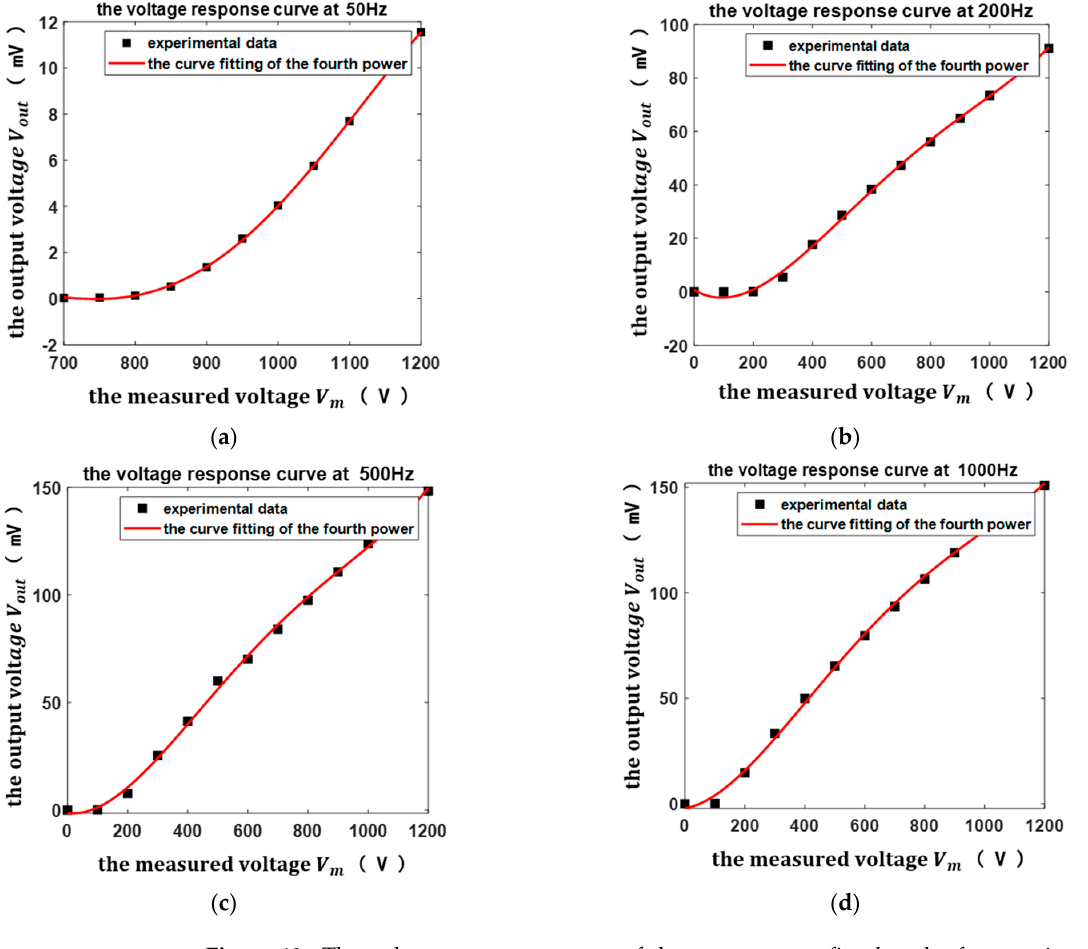
Figure 12. The voltage response curves of the sensor curve-fitted at the frequencies: ( a ) 50 Hz; ( b ) 200 Hz; ( c ) 500 Hz; ( d ) 1000 Hz.